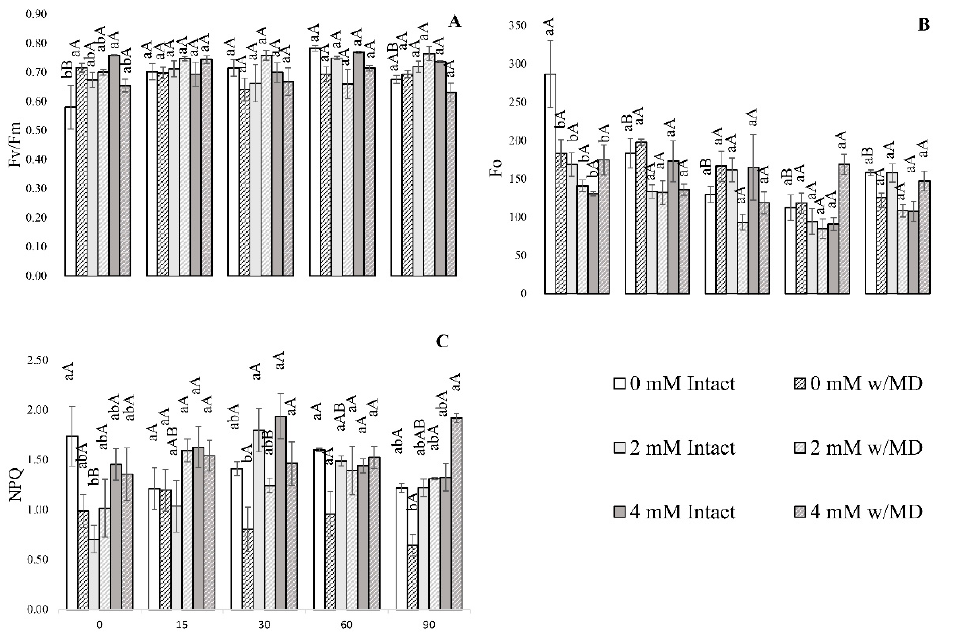
Figure 1. ( A ) Maximum quantum yield of PSII photochemistry (Fv/Fm) p < 0.028; ( B ) Minimum Chl a fluorescence yield in the dark-adapted state (Fo) p < 0.033; ( C ) Energy dissipation as heat observed by non-photochemical quenching (NPQ) p < 0.036 in Annona emarginata plants submitted to the treatments: 0 mM Ca 2+ without mechanical damage (intact), 0 mM Ca 2+ with mechanical damage (w/MD), 2 mM Ca 2+ intact, 2 mM Ca 2+ w/MD, 4 mM Ca 2+ intact, and 4 mM Ca 2+ w/MD, at evaluation times: 0 (30 min) 15, 30, 60, and 90 days. Values correspond to means ± SE ( n = 4). Lowercase letters indicate differences between treatments within each evaluation time and uppercase indicate differences between each treatment over evaluation time.